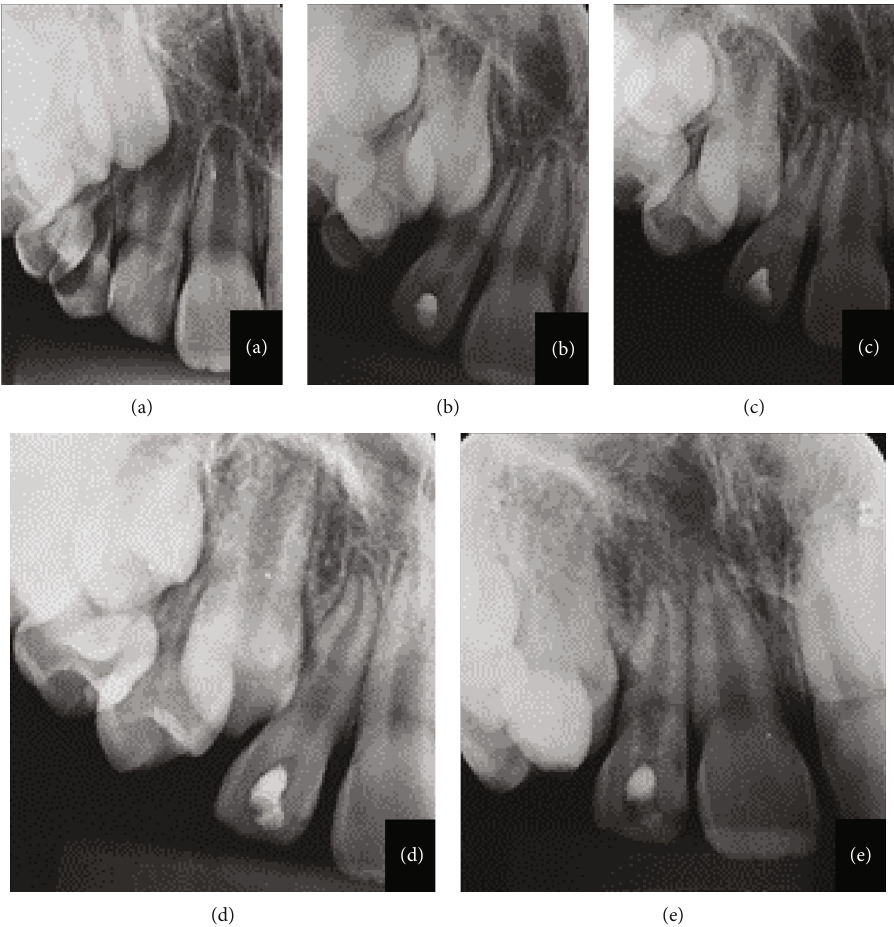
Figure 3: (a – e) 26-month radiographic follow-up: periapical radiography before endodontic access and root perforation (a); maxillary lateral incisor with evidence of coronal access (b); follow-up at 14 (c) and 20 (d) months; evidence of complete rhizogenesis